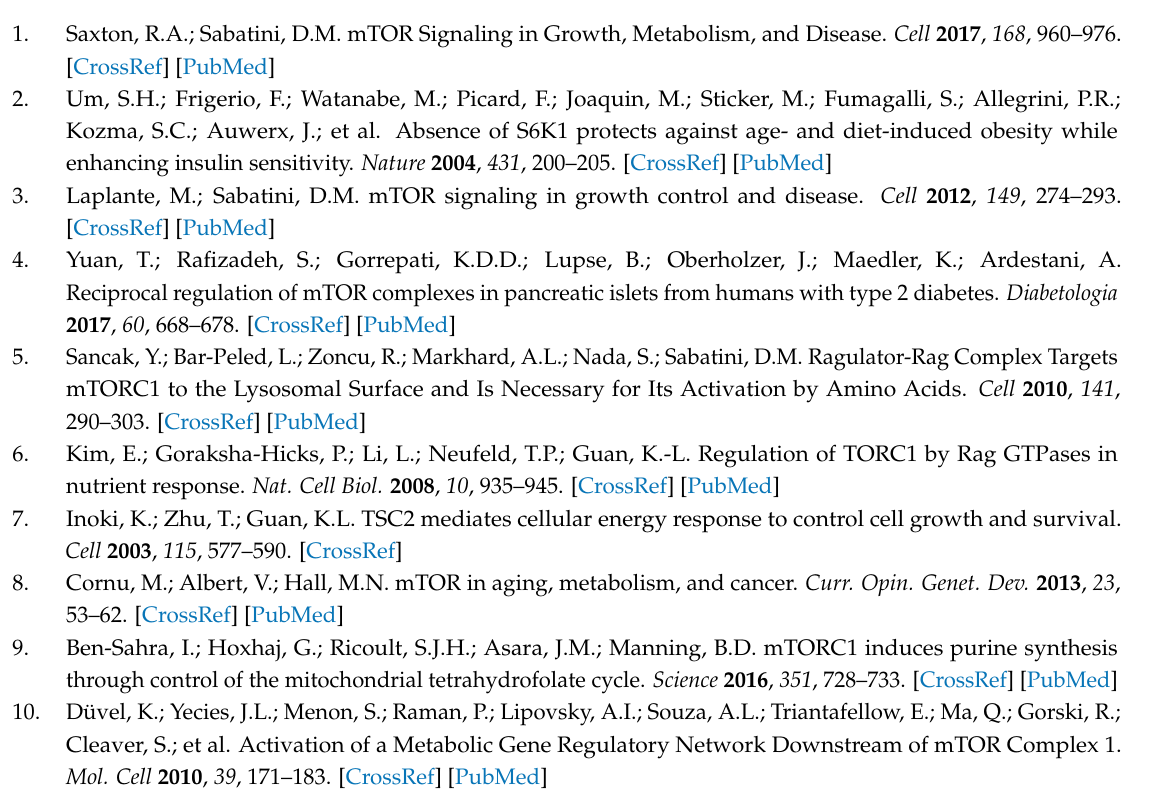
Table 1. The effects of altered mTOR signaling on glucose and lipid metabolism in metabolic tissues. mTORC1 mTORC2 Normal adipose tissue growth [16]; Regulate fat and whole body organ size [21]; systemic Adipose tissue BAT-WAT phenotypic switch [18–20] glucose and lipid metabolism [22]; BAT differentiation [25] Suppress ketogenesis in response to fasting [27]; promote Regulate constitutive gluconeogenesis, increase glycolysis Liver lipogenesis [28,29] and lipogenesis [35,36] Promote glucose uptake and improve insulin signaling [51]; Glucose intolerance and insulin resistance, negatively modualtes systemic lipid metabolism and Muscle hypertrophy [42,43] intramyocellular triglycerid content [52,53] Promote beta cell growth and proliferation [54–58]; improved glucose tolerance in short term, deteriorates beta Maintaining beta cell mass and glucose homeostasis [72] Pancreas cell mass and function in long term [60,61]; maintain α cell maturation and glucagon secretion [68] Brain Regulate fat mass and adiposity, and glucose tolerance